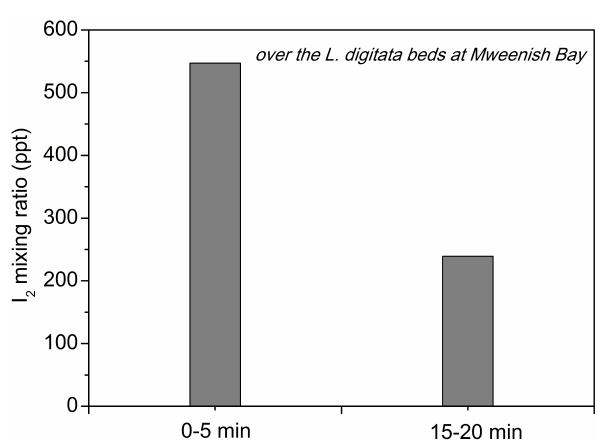
Fig. 2. I 2 mixing ratio against the exposure time of L. digitata beds observed at site #3. Here, the first sample (from 0–5min) was taken when L. digitata was just exposed to air. Following an interval of 10min for setting up the second sampler, the second sample (from 15–20min) was taken. The data set is limited to two measurements because the L. digitata beds were accessible only at a single spring low tide at Mweenish Bay, which explains the lack of error bars in this Figure.